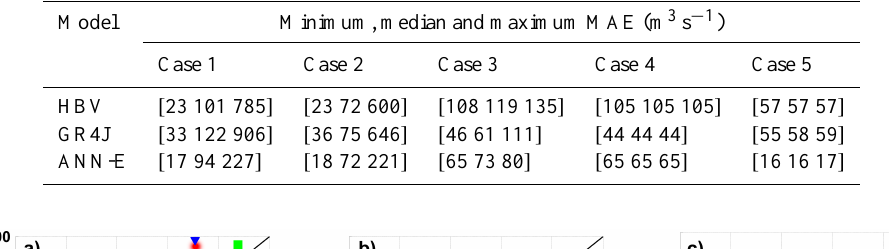
Table 7. Minimum and maximum prediction errors for low-flow forecasts for a lead time of 90 days during the test period 2002–2005.